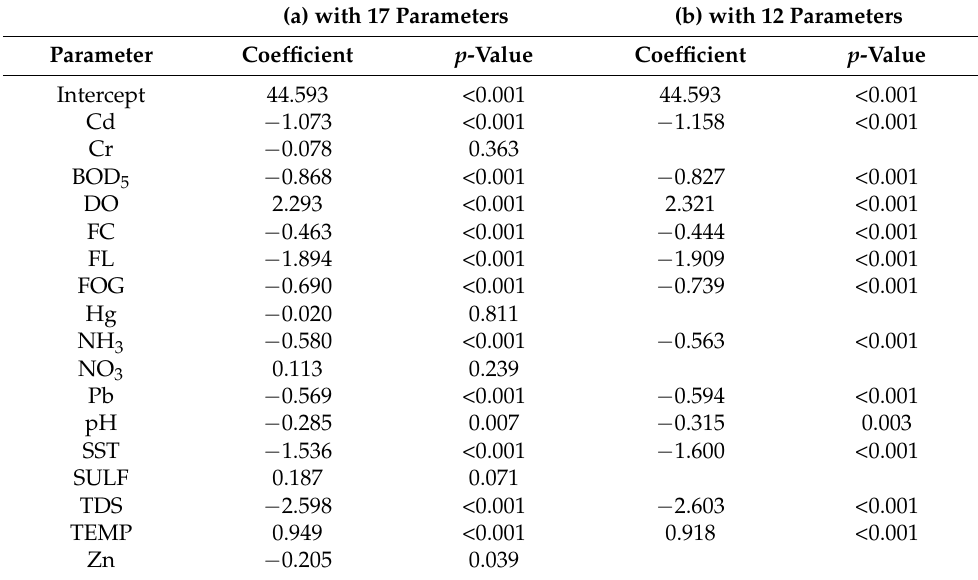
Table 4. Multiple linear regression models’ coefficients and p